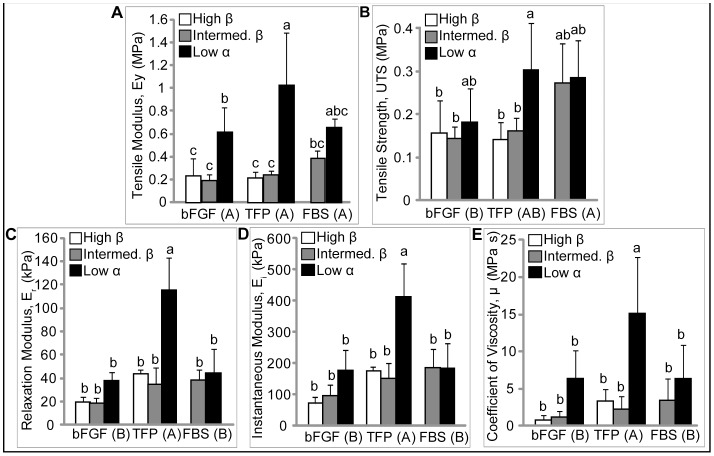
Mechanical Properties of Neotissue.Mechanical properties were assayed after 4 wks culture. Tensile modulus, Ey, (a), ultimate tensile strength, UTS, (b), compressive relaxation, Er, (c) and instantaneous Ei, (d) moduli, and coefficient of viscosity, μ, (e) are reported. Compressive properties are reported for 20% strain. Low seeding density significantly increased all mechanical properties assayed. TFP significantly increased compressive properties. All data is presented mean ± s.d. Individual factor levels or groups not possessing a common letter are significantly different.